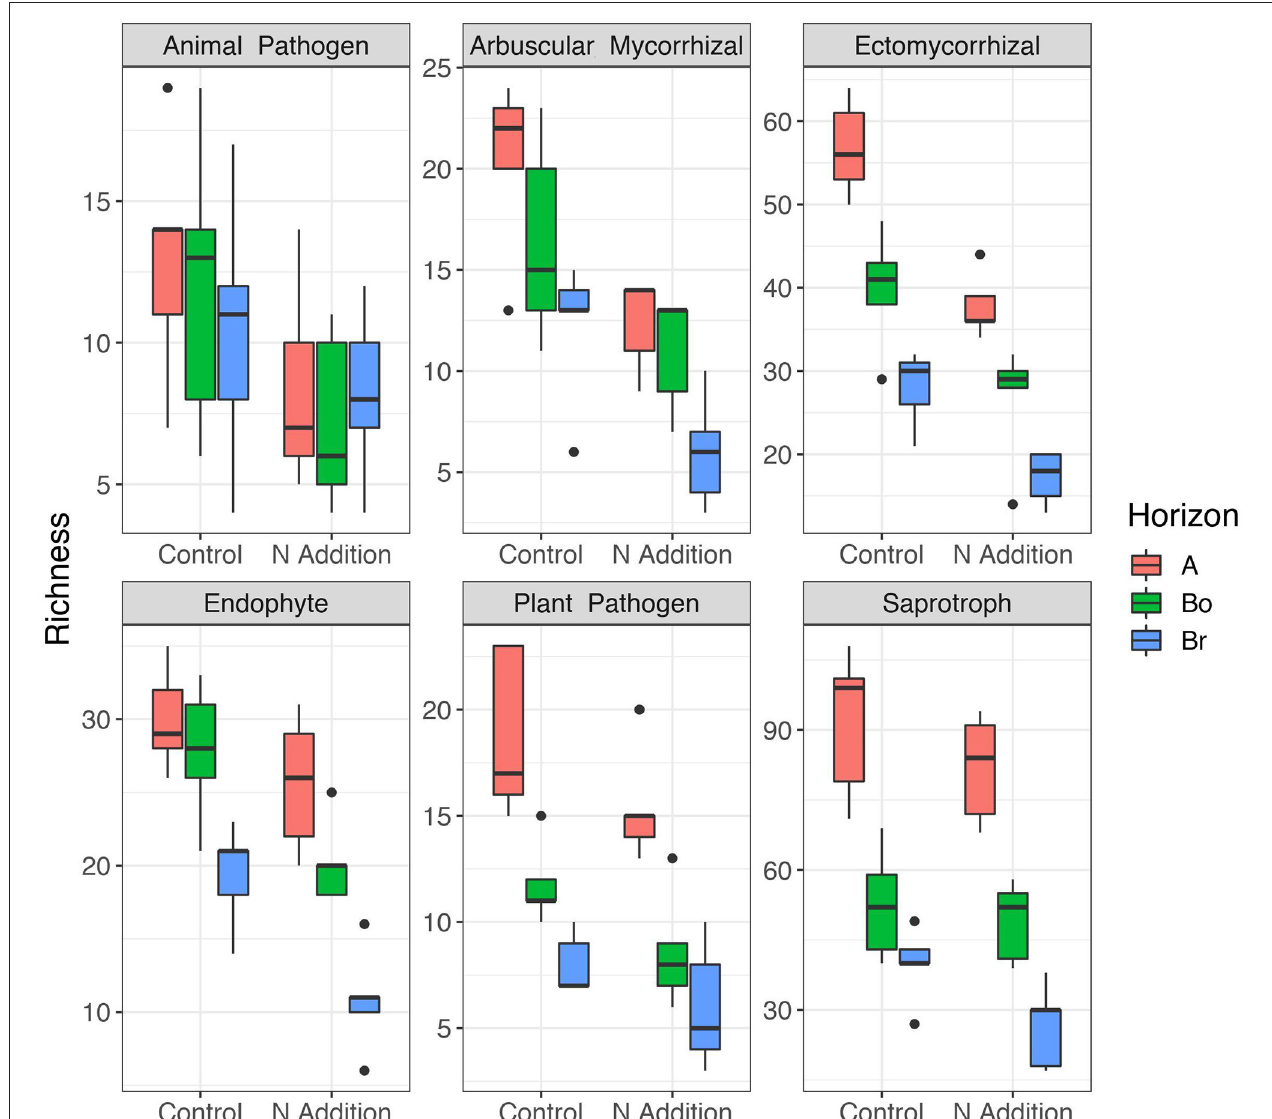
FIGURE 4 | Patterns of α -diversity (Richness) of the different fungal guilds in the horizons of the mineral soil in the control and N-addition plots ( n = 5; A, A horizon; Bo, oxic B horizon; Br, reduced B horizon). Fungal functional guilds were analyzed by FUNGuild showing the six most abundant guilds. Only the guild assignment with “highly probable” confidence rankings was